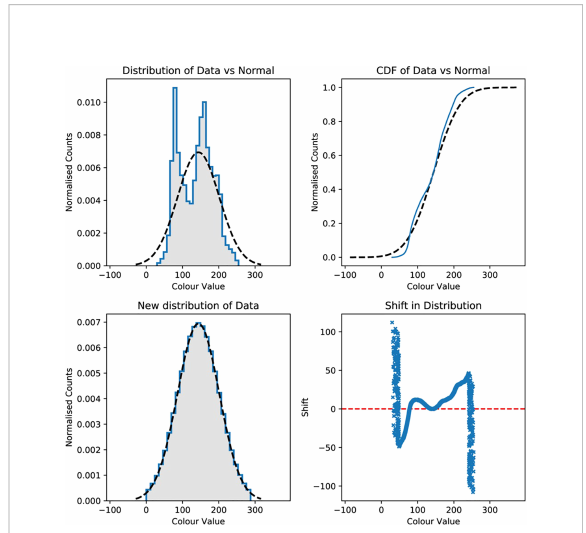
FIGURE 3 Illustration of how a non-normal distribution is transformed to Gaussian form via Equation 1. The top-left panel shows the distribution of raw data (shaded histogram, in this case ‘ colour value ’ ) overlaid by a normal distribution (dotted line) with similar values for median m and standard deviation s . The equivalent cumulative distribution functions (CDFs) are shown in the top- right panel. The bottom-right panel presents the shift necessary to transform each value onto the target normal distribution. Note that the vertical spikes present on left and right of the shift curve are due to clipping at ±2.5 s . The fi nal distribution is shown in the bottom-left panel and corresponds well to the Gaussian curve, despite the clipped